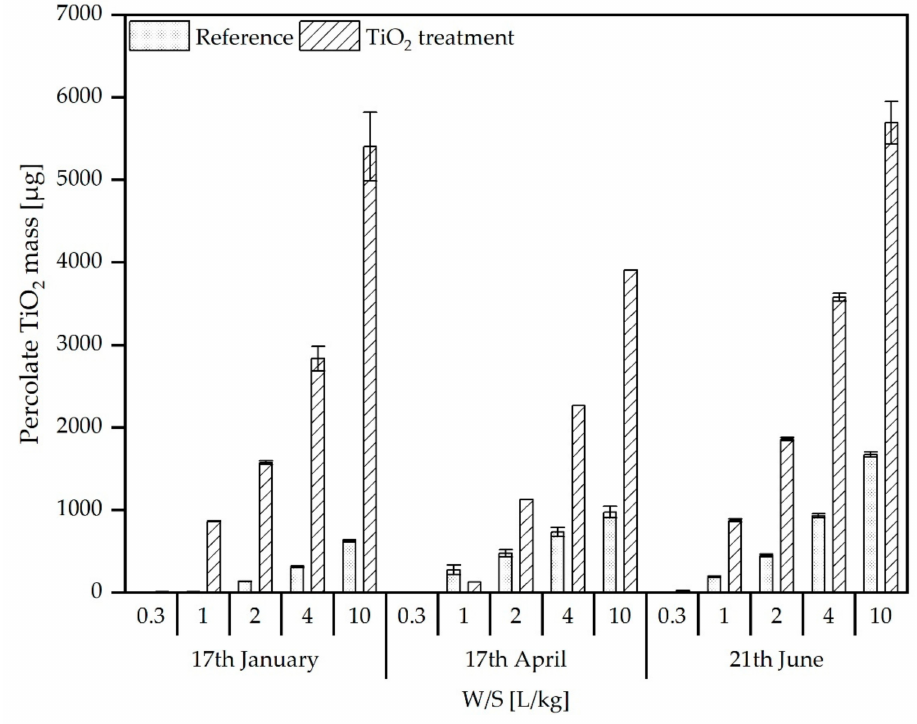
Figure 5. Total TiO 2 content ( µ g) in column percolates from reference and nTiO 2 treated SSA/soil mixtures out of pilot scale simulation reactors collected at three different sampling